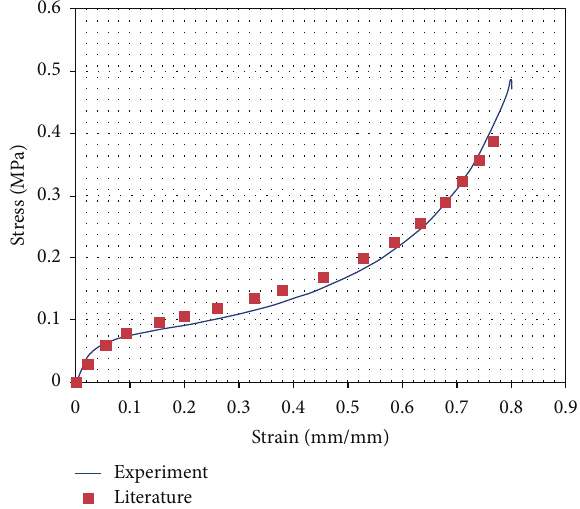
Figure 3: Comparison between literature data and experimental data.